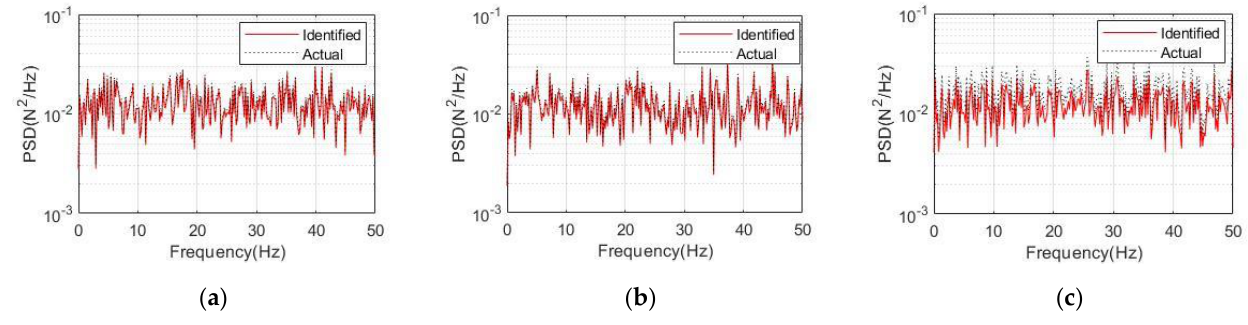
Figure 3. Estimation of the random forces. ( a ) Force 1; ( b ) force 2; ( c ) force 3.